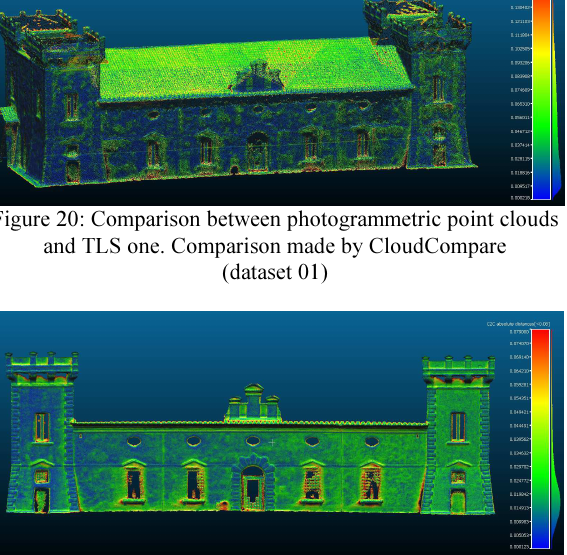
Figure 21: Comparison between photogrammetric point clouds and TLS one. Comparison made by CloudCompare (dataset 02)